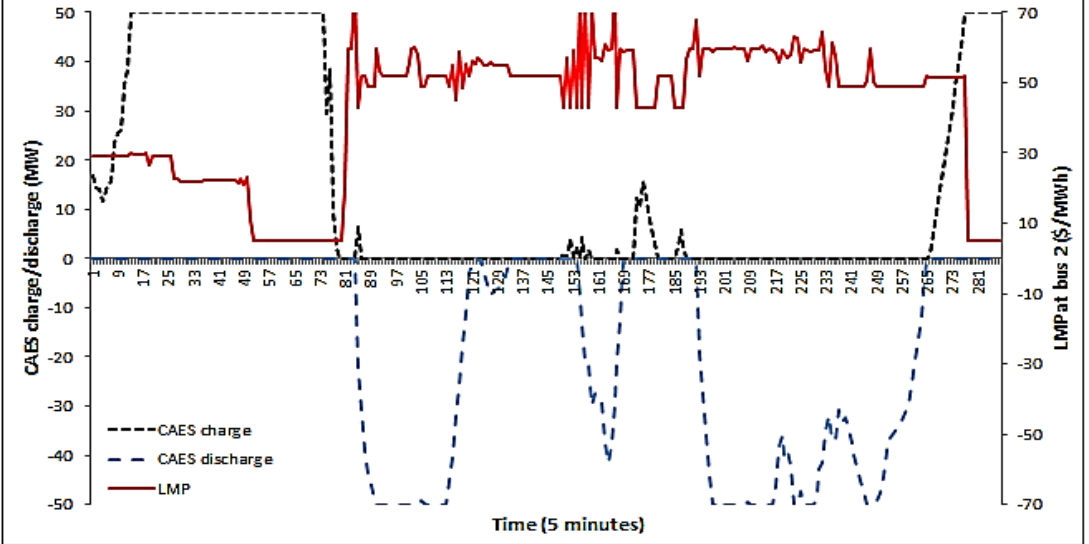
Figure 9. CAES RT charge/discharge values and RT LMPs at bus 2 under scenario